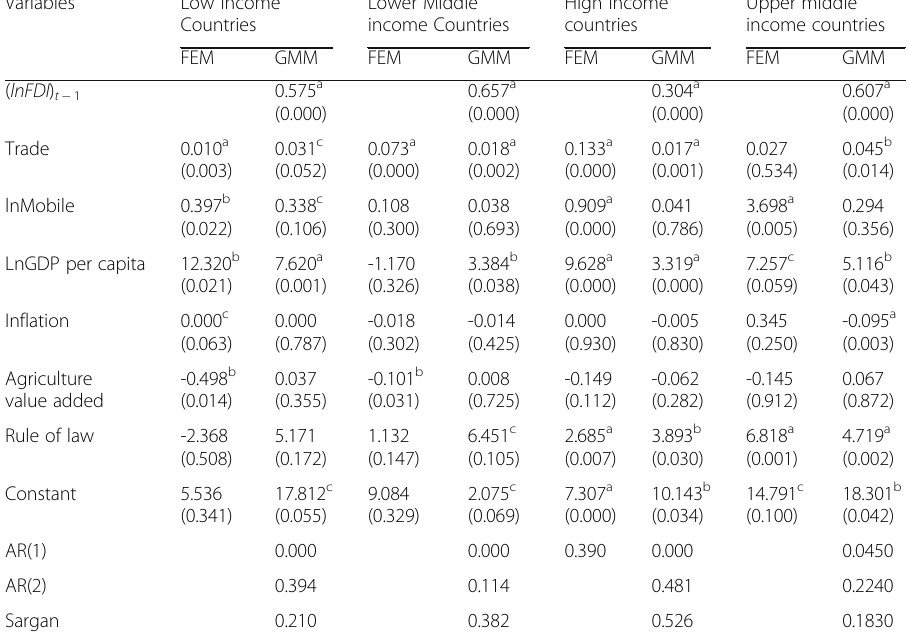
Table 14 Rule of Law and FDI Variables